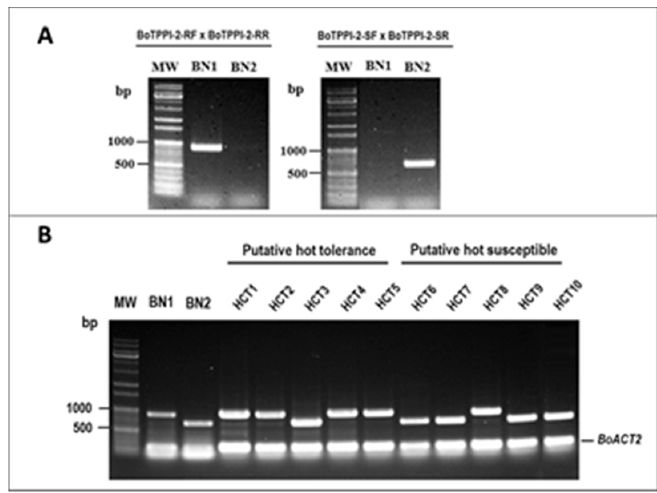
Figure 7. Development and validation of the PCR-based marker used for the identification of HT-tolerant and -susceptible cabbage genotypes. ( A ) Marker development using two different primer sets: BoTPPI-2-RF/-RR for the HT-tolerant (BN1-type) allele and BoTPPI-2-SF/-SR for the HT-susceptible (BN2-type) allele. ( B ) Marker validation using cabbage inbred lines obtained from Choen Seed Co. The same primer sets were used as in A, and PCR products were separated on 1% agarose gel. Brassica oleracea Actin2 ( BoACT2 ) was used as a